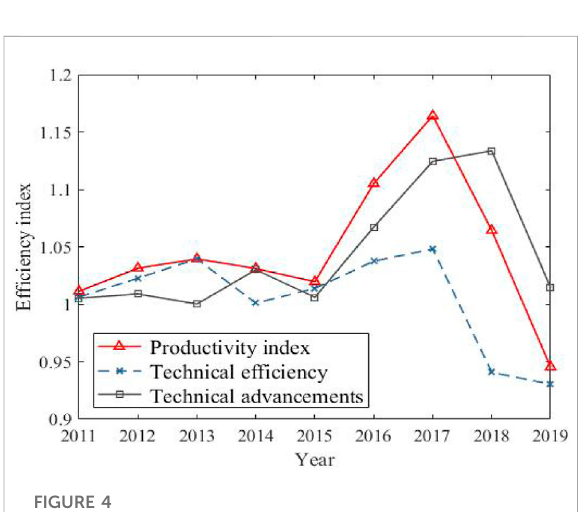
FIGURE 4 Trends of various factors in aquaculture ef fi ciency by